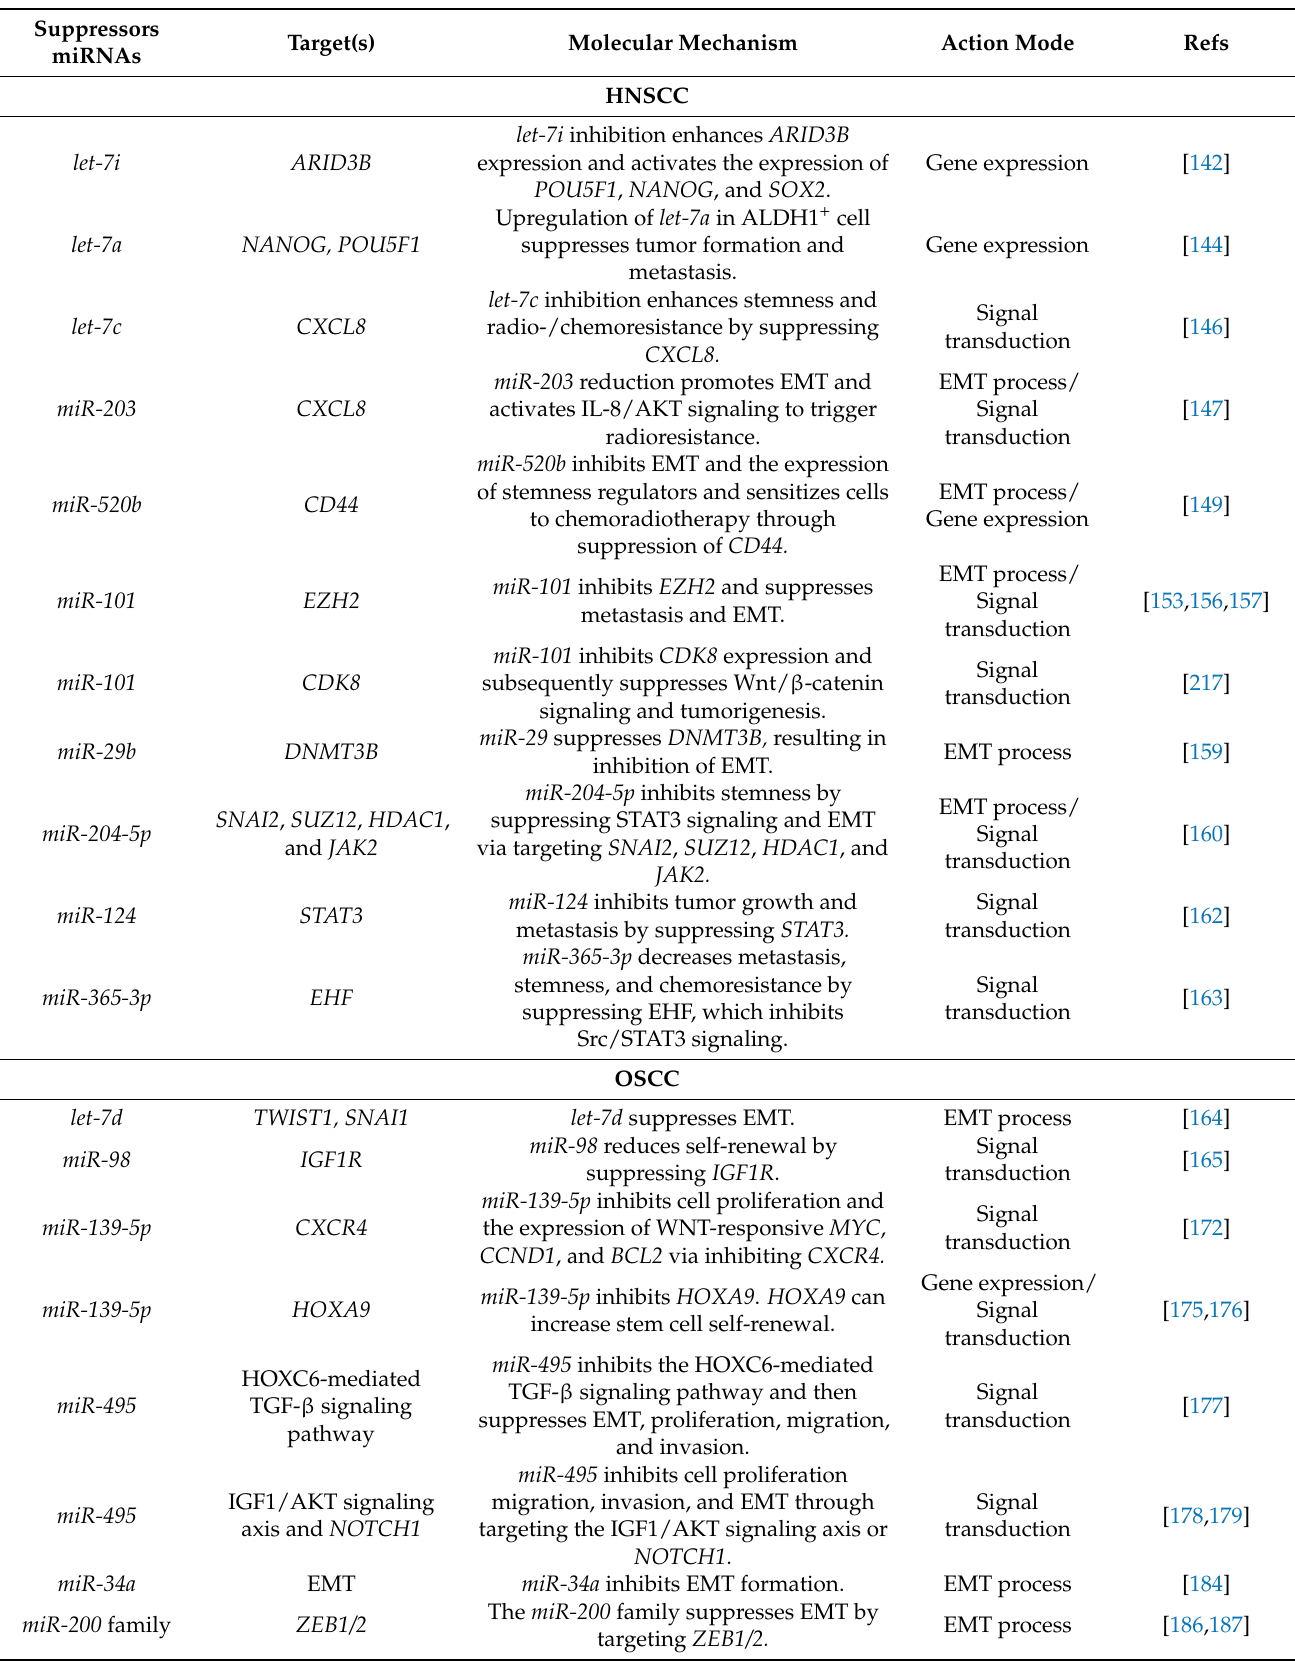
Table 2. miRNAs as tumor suppressors that are involved in the stemness of head and neck squamous cell carcinomas